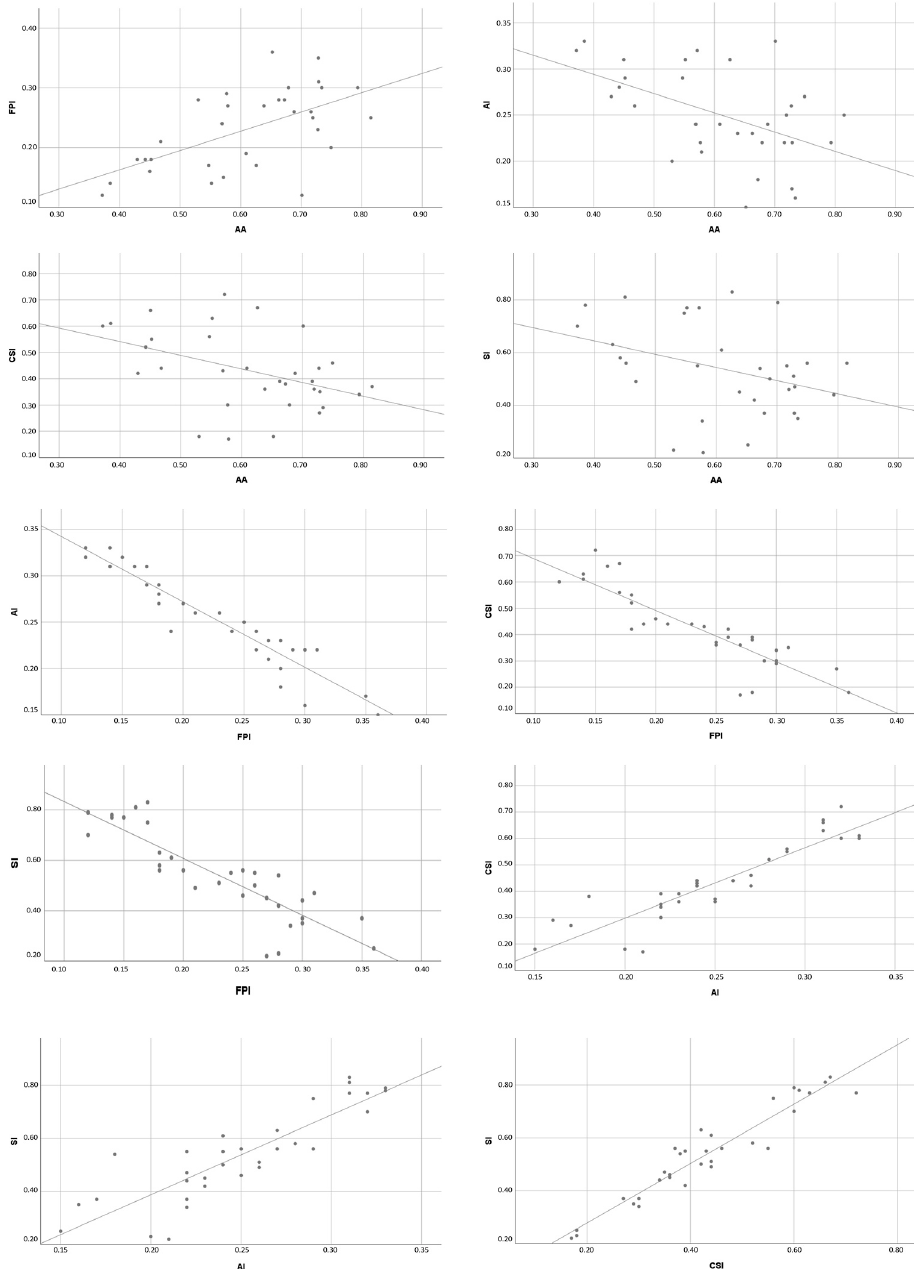
Figure 2. Significant correlations result in flatfoot subjects.